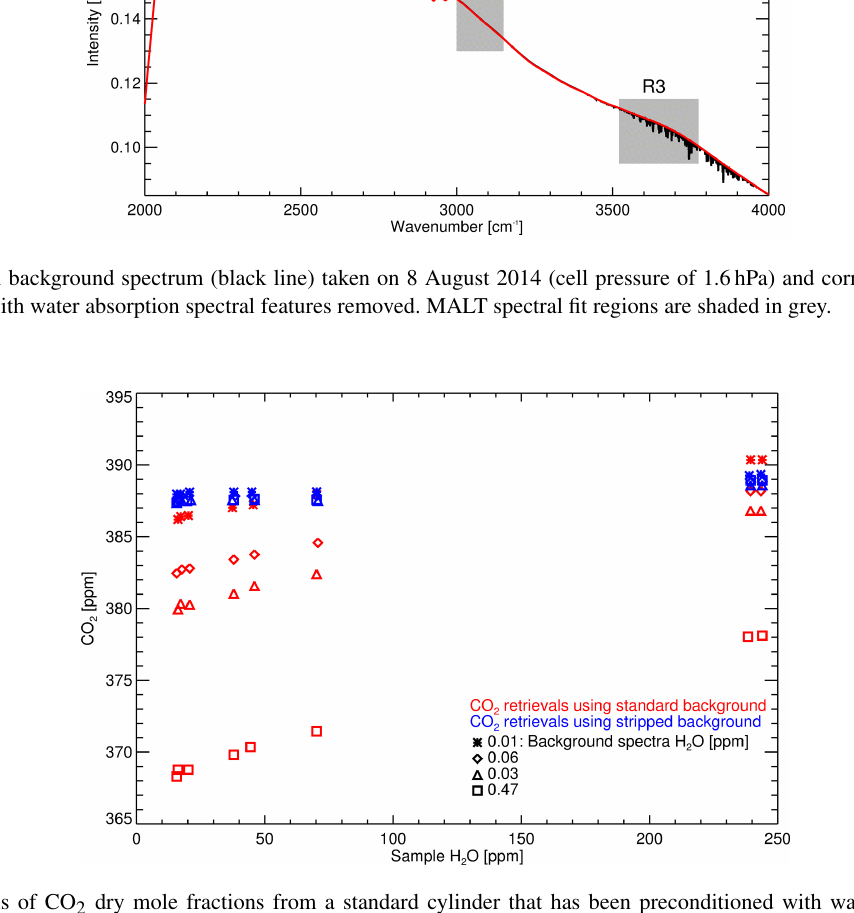
Figure B2. Retrievals of CO 2 dry mole fractions from a standard cylinder that has been preconditioned with water vapour of differing amounts using unaltered background spectra (red) and stripped background spectra (blue). The legend displays the amount of retrieved water vapour in the four background spectra. All background spectra were taken with the cell evacuated to approx.